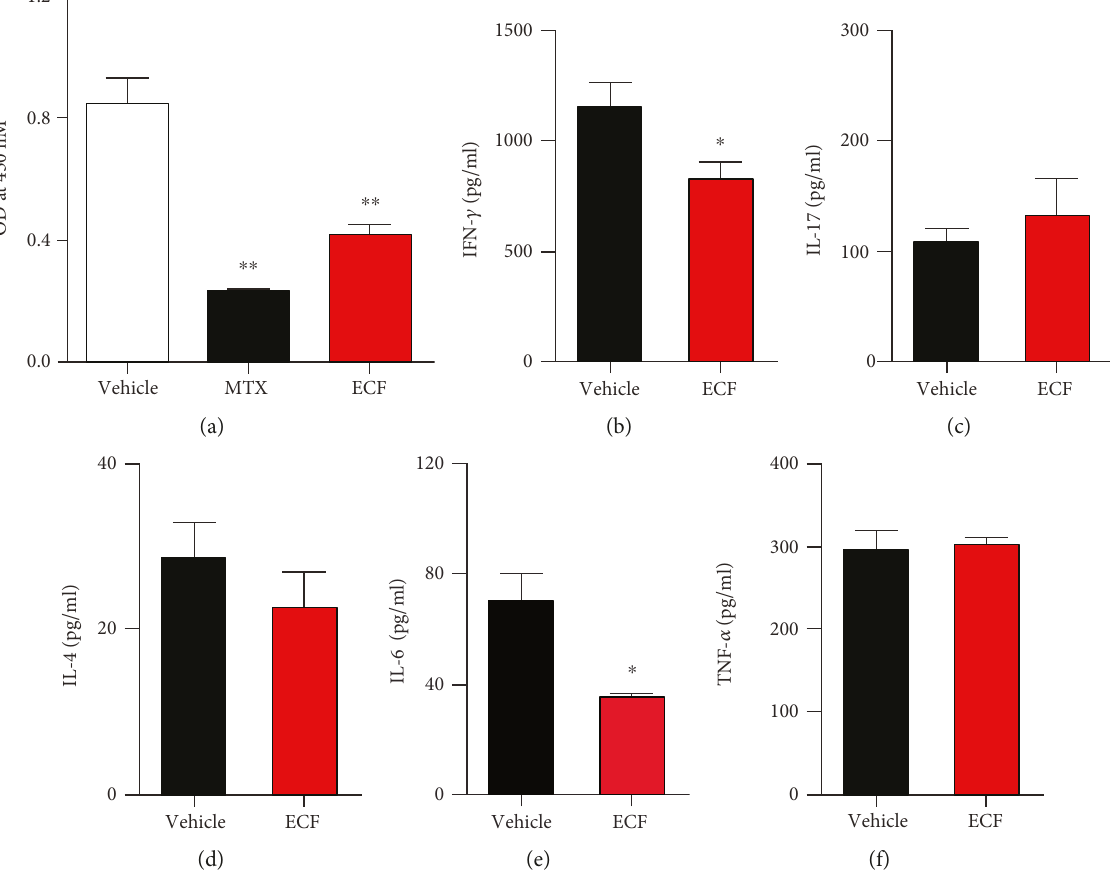
Figure 3: ECF inhibits CII-speci fi c immune responses. Splenocytes (5 × 10 5 cells/well) from CIA mice were recalled with 100 μ g/ml CII. After 72h, splenocyte proliferation assay was performed using CCK-8 Kit. Culture supernatants were harvested at 48 h, and IFN- γ , TNF- α , IL-17A, and IL-4 levels were measured by ELISA. Results presented are mean ± s.e.m., n = 4 . ∗ P < 0 05 , ∗∗ P < 0 01 versus vehicle